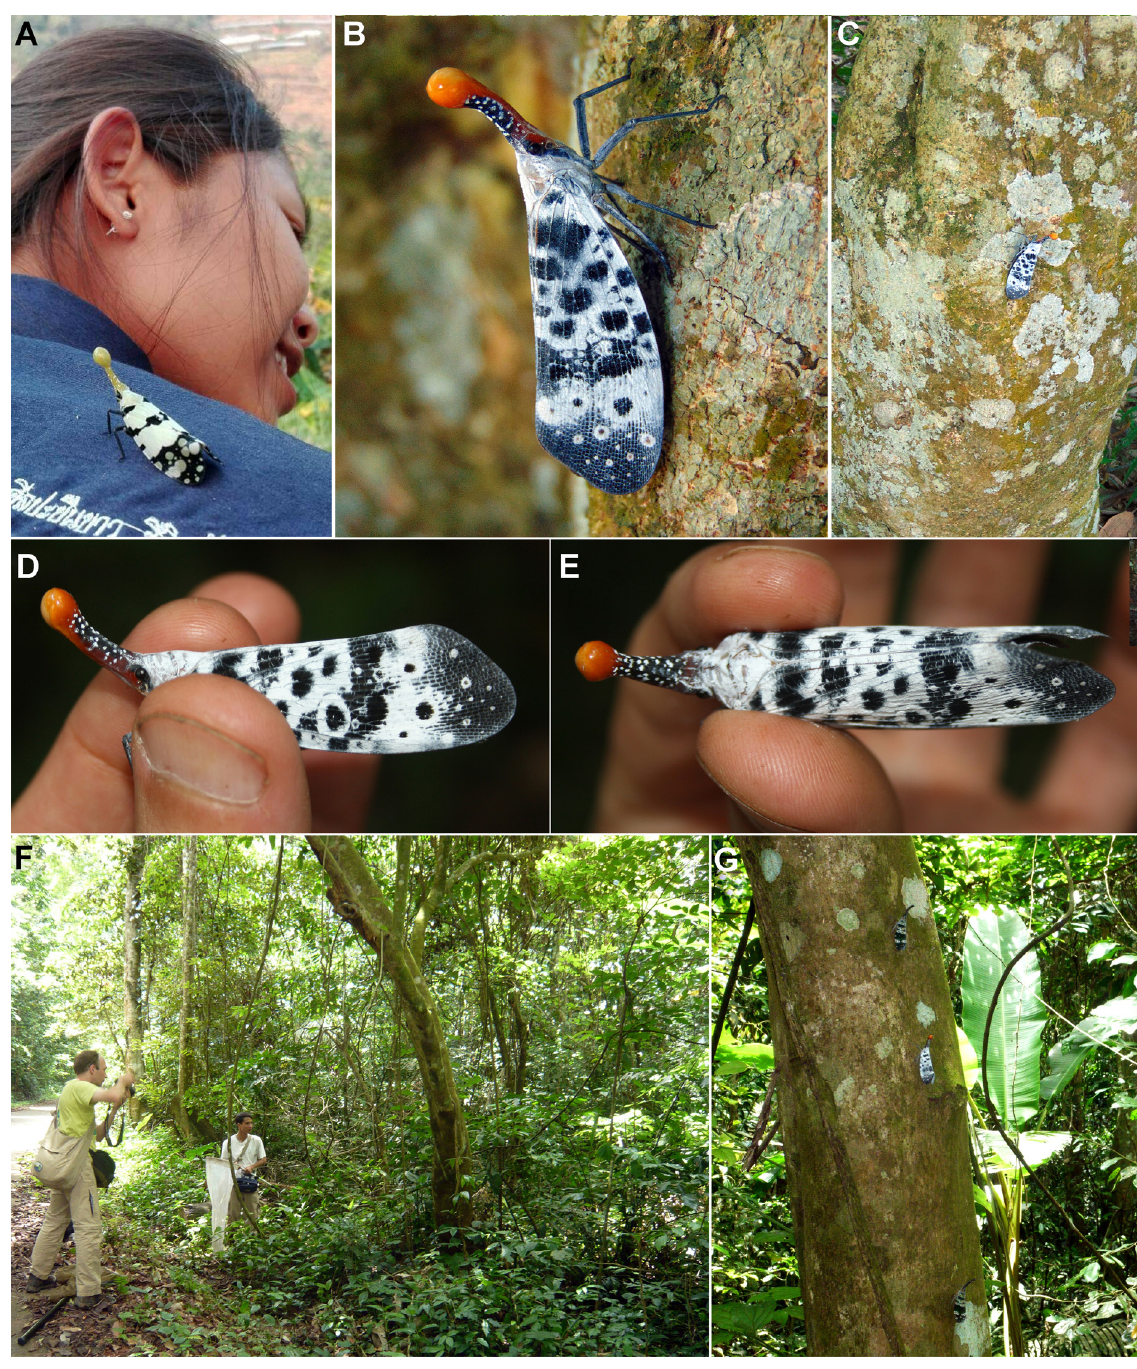
Fig. 9. Specimens of Pyrops clavatus group in nature. A . P. atroalbus (Distant, 1918) comb. nov. in Maerim District, N Thailand, 14 Mar. 2016 (photograph by P. Jirasuttayaporn). B–C . P. clavatus (Westwood, 1839) on a trunk of Dimocarpus longan (Sapindaceae) at Me Linh Biological Station, N Vietnam, 12 Jul. 2015 (photographs by J. Constant). D–E . P. clavatus (Westwood, 1839) in Cuc Phuong National Park, N Vietnam, 21 Jul. 2011 (photographs by J. Constant). F . The authors in the habitat of P. clavatus (Westwood, 1839) in Cuc Phuong National Park, N Vietnam, 21 Jul. 2011 (photograph by J. Bresseel). G . P. clavatus (Westwood, 1839) together with P. spinolae (Westwood, 1842), specimens in Cuc Phuong National Park, N Vietnam, 21 Jul. 2011 (photograph by J.